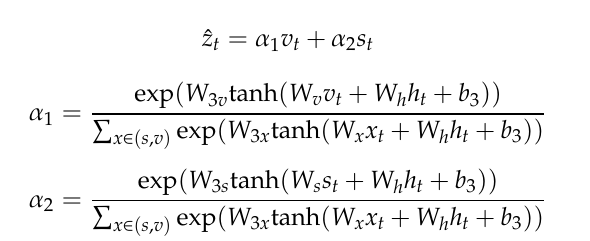
Figure 5. The architecture of attention3. This structure can learn a set of weights, which reflect the degree of attention to visual and semantic information. attention2, respectively.